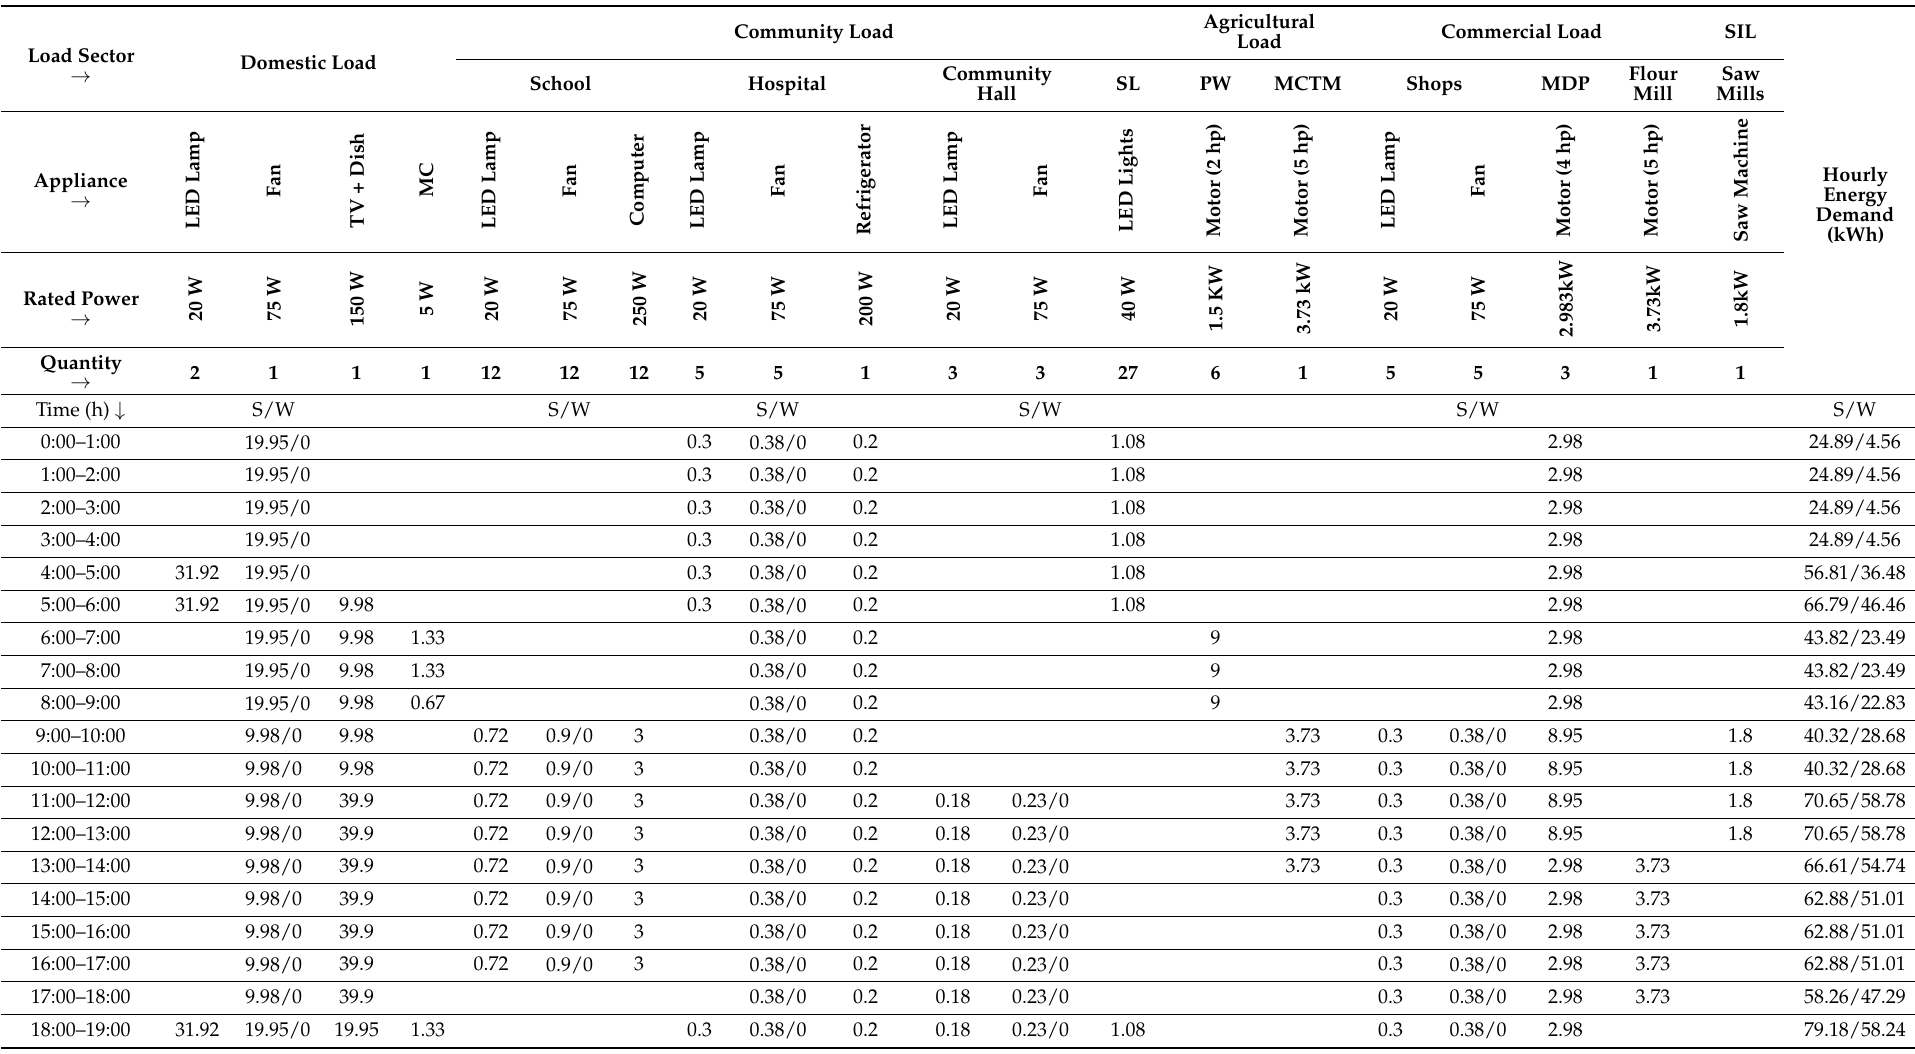
Table 1. HPRALC-based scenario load demand for both winter and summer